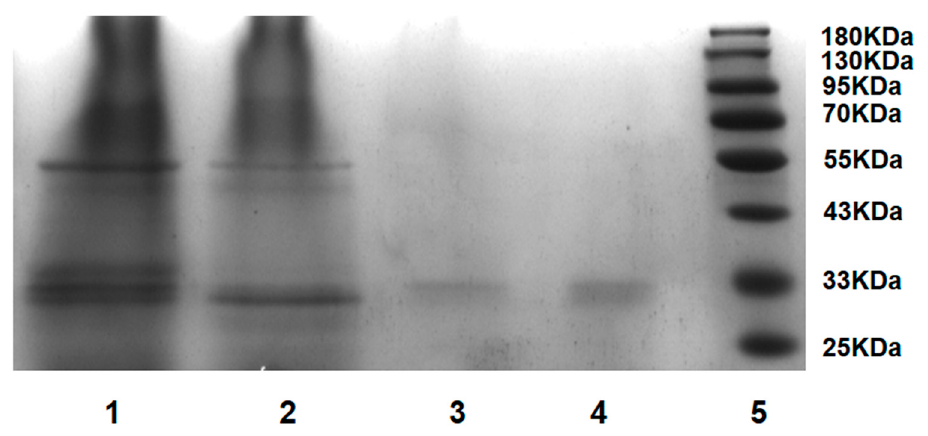
Figure 8. SDS-PAGE analysis of purified PrK. Lane 1: Tritirachium album Limber crude enzyme fluid; Lane 2: supernatant after adsorption by Co 4 PW–PDDVAC composite; Lane 3: recovered solution; Lane 4: standard PrK (500 μ g mL − 1 ); Lane 5: protein marker. Table 4. Comparisons of the performance of PrK isolation procedures.